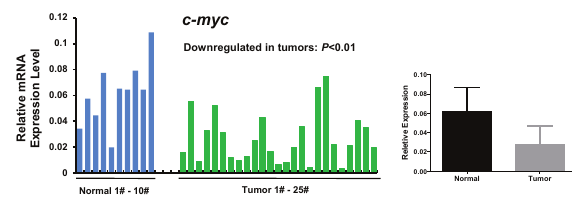
Figure 1: c-myc expression in adenocarcinoma of esophagogastric junction tissue samples.